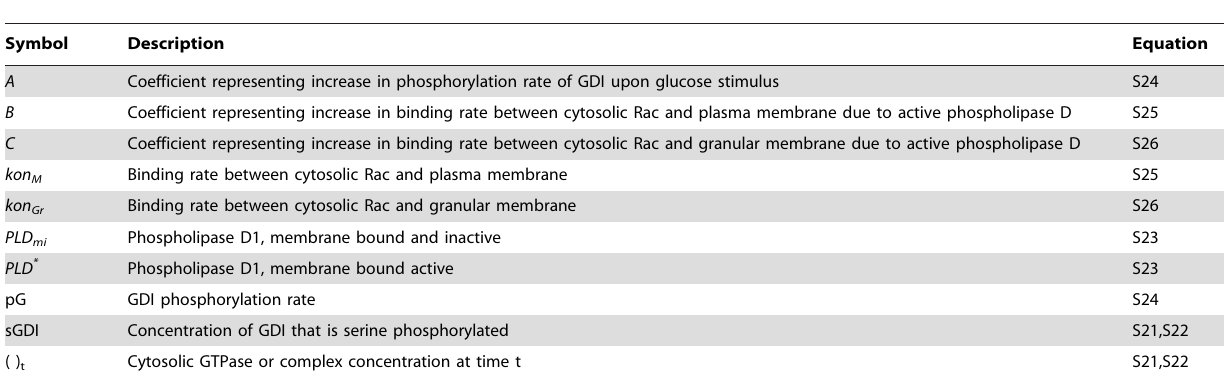
Table 3. Variables and parameters used in ‘Application to Rac cycling in pancreatic b -cells’.